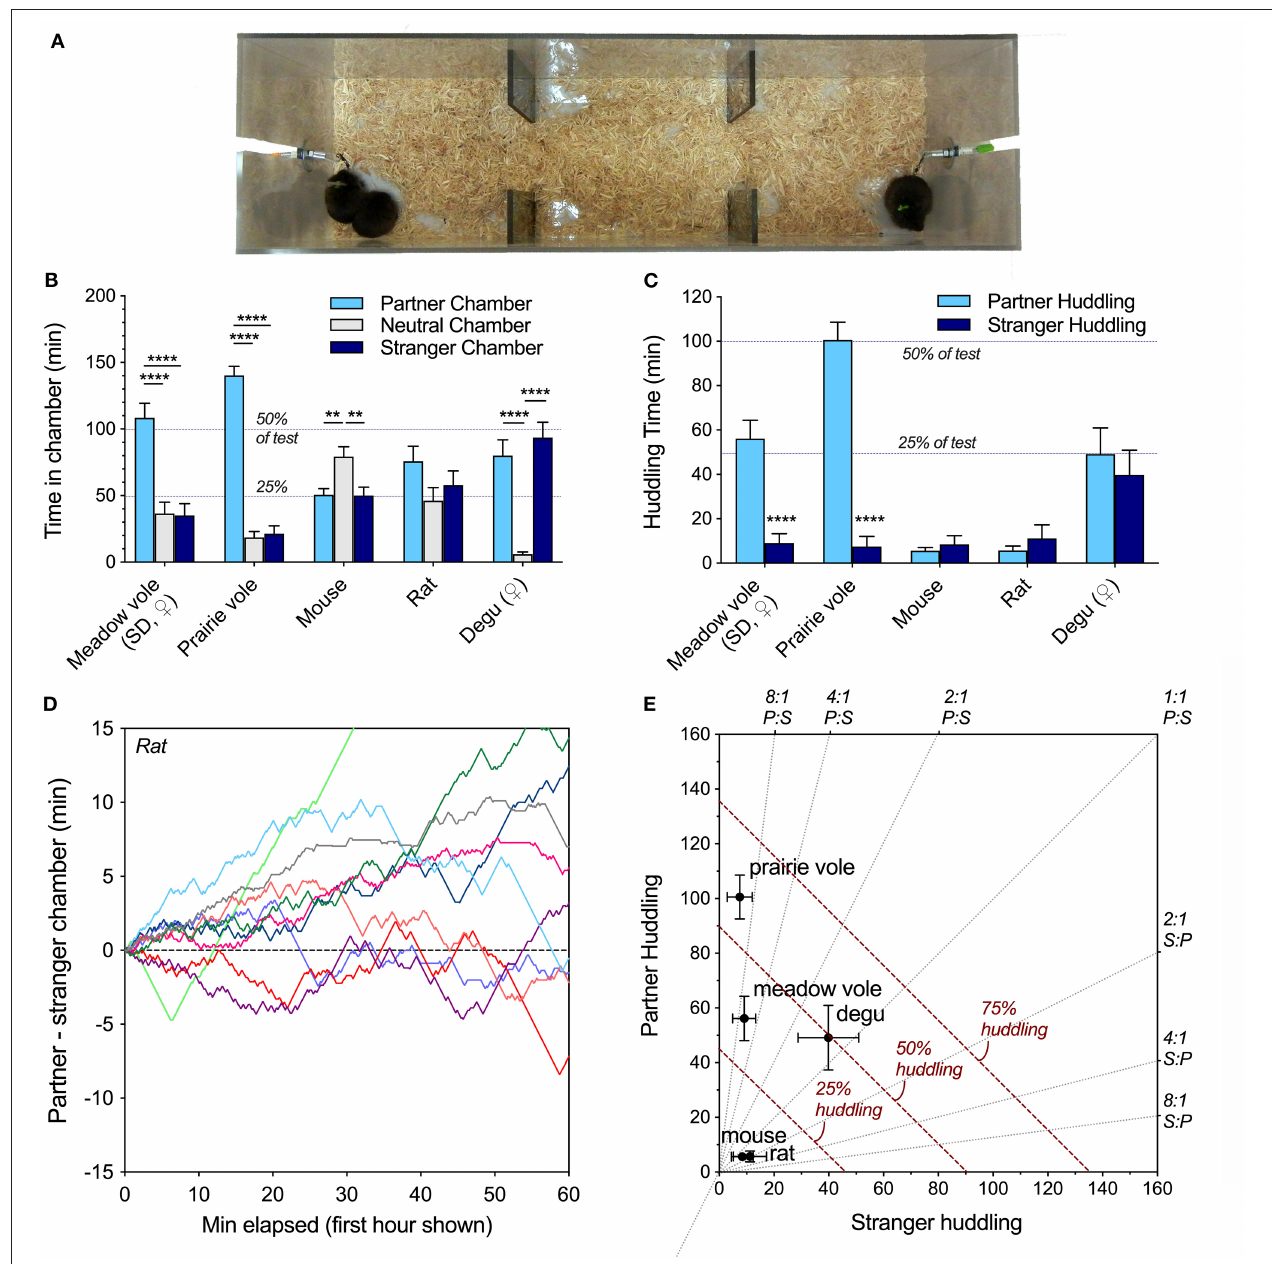
FIGURE 1 | (A) Linear partner preference test configuration, shown here with meadow voles. One familiar and one novel individual is tethered at each end. In the peer partner preference test, all animals are of the same sex. (B) Species differences were evident in chamber time, with partner selectivity in meadow and prairie voles, preference for the empty chamber in mice, no preferences in rats, and preference for either occupied chamber in degus. (C) Selectivity of same-sex peer social interaction across species. Both meadow and prairie voles exhibit selective partner preferences for familiar same-sex peers, while mice, Long-Evans rats, and degus did not. (D) Visualization of the time spent in the partner vs. stranger chamber of the PPT apparatus during the 1st h did not reveal the social novelty preferences sometimes displayed by juvenile rats in 10 or 20min preference tests using barriers. (E) An alternate representation of huddling across species highlights variation in both selectivity and total huddling behavior. Gray lines represent level of selectivity. Dashed red lines represent duration of the test spent huddling. Asterisks (** = p < 0.01, **** = p < 0.0001) represent significant differences within species; see Table 2 for statistical comparisons between species. expected values in the absence of preferences (0 for P-S time; huddling preferences were extracted for the prairie vole cohort, 50% for preference score) using one-sided t -tests if data were and partner and stranger huddling were compared at half-hour normally distributed or Wilcoxon signed rank tests if they intervals. Summary measures (partner-stranger (P-S) chamber were time, P-S huddling, and preference score) were compared to